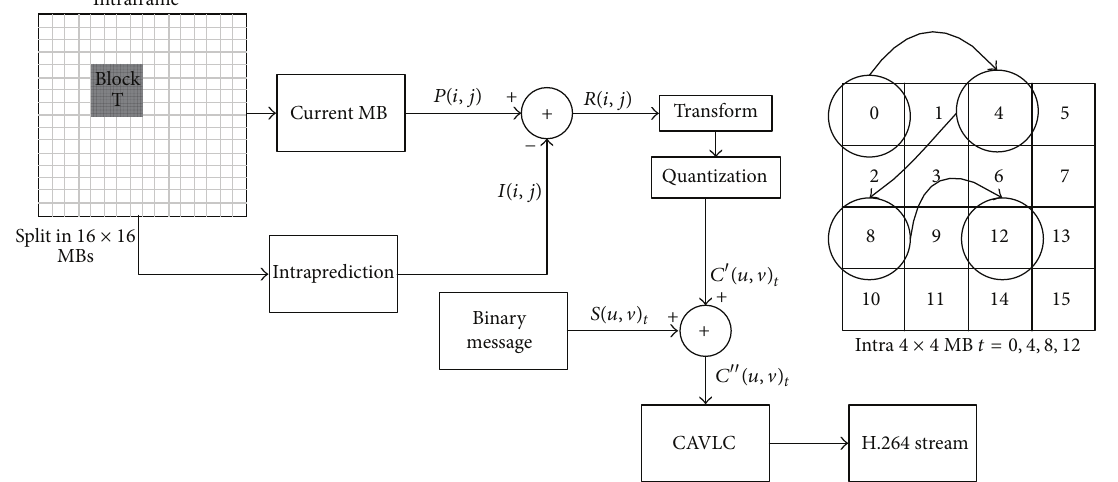
Figure 2: Steganography in